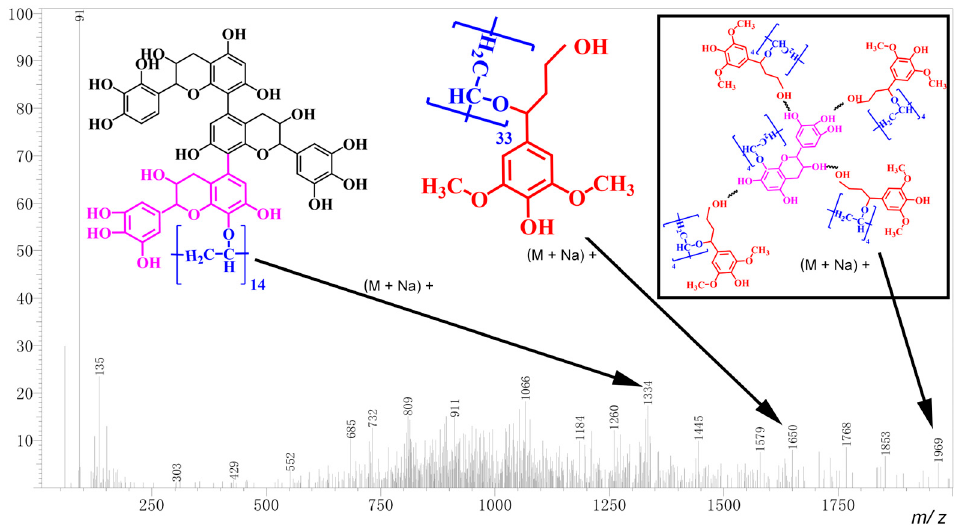
Figure 2. ESI-MS spectra of tannin-lignin-PVOH (TLP) film.